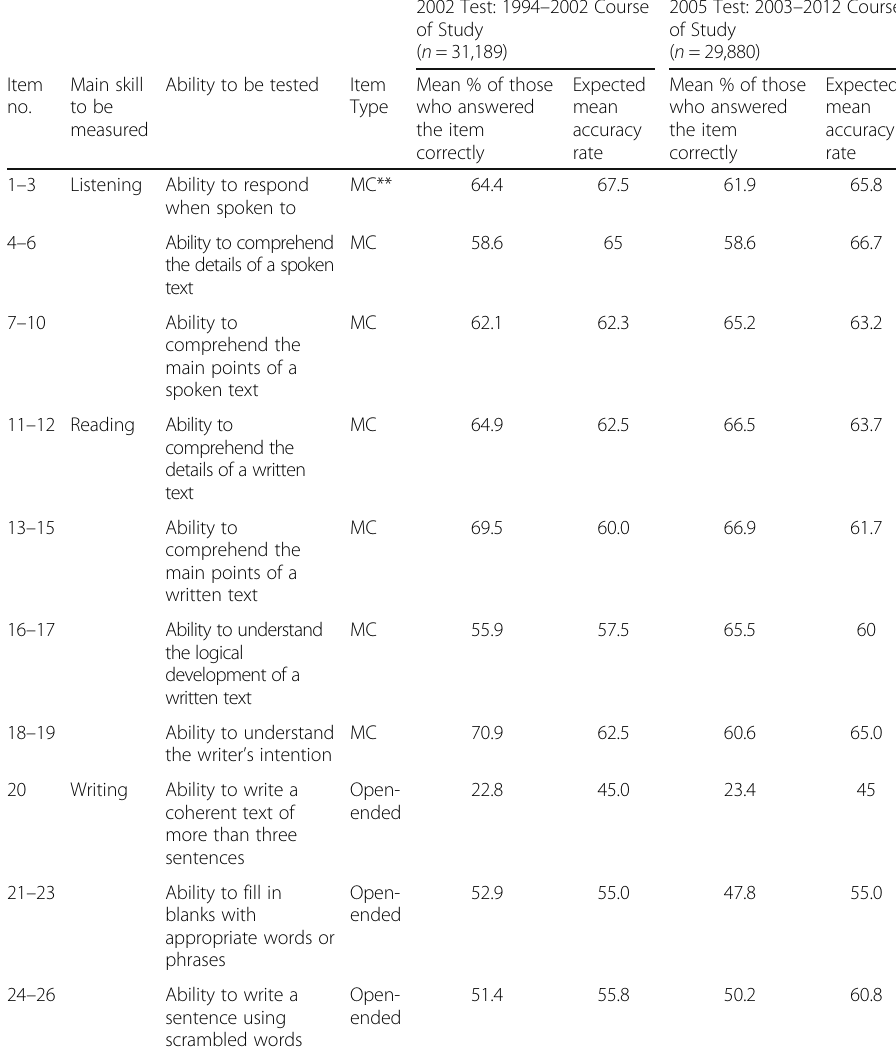
Table 2 Specifications, accuracy rates, and other information regarding the English items in the 2002 and 2005 senior high school tests*